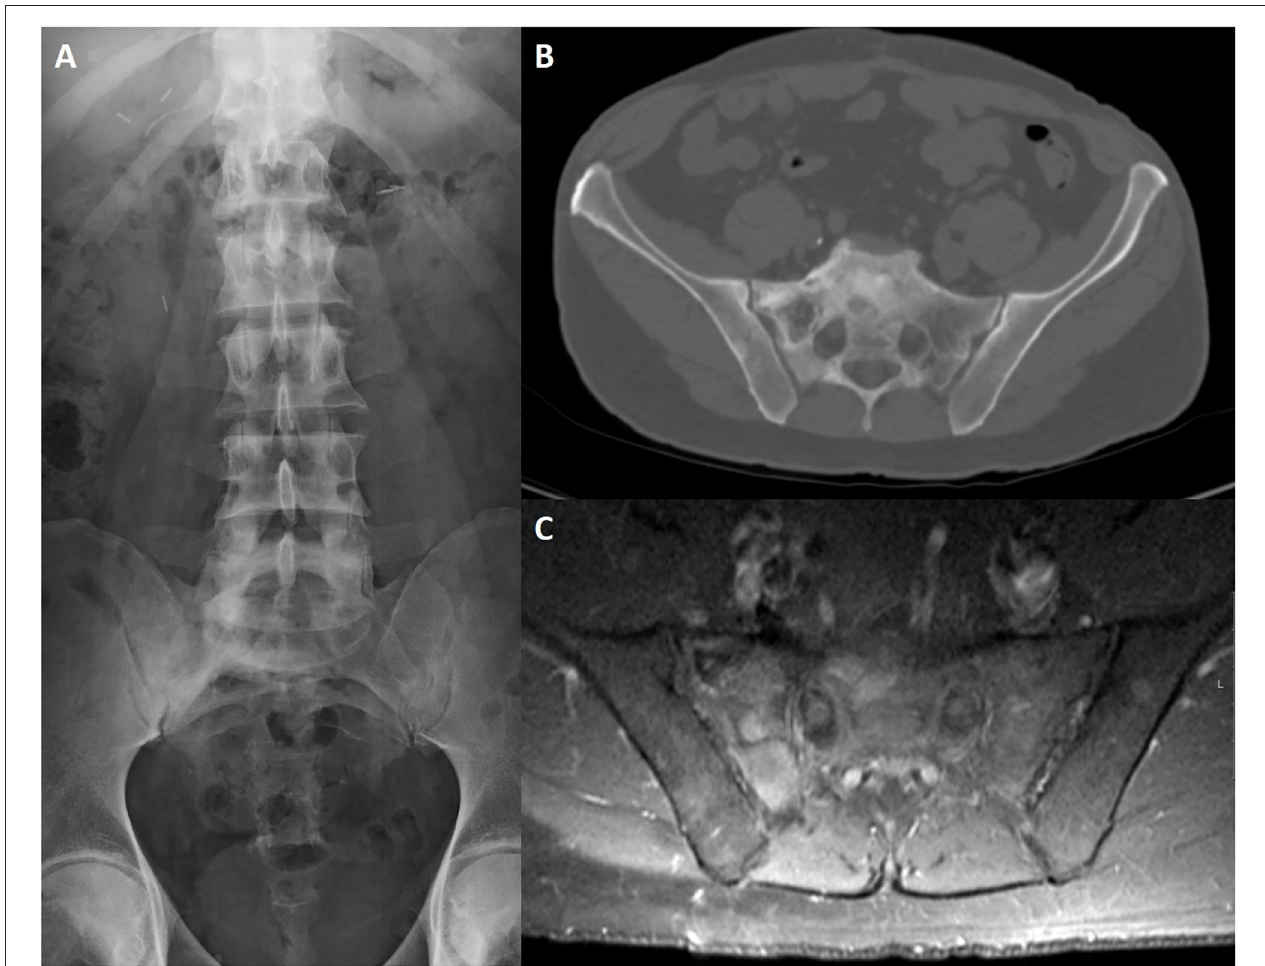
FIGURE 12 | Lumbosacral radiography (A) , CT axial slice (B) and post-contrast fat-saturated T1WI (C) of a 65-year-old male patient with Paget disease of the sacrum and right iliac bone. Typical findings include an expanded bone with coarsened trabecular pattern and sclerotic changes that are more evident on conventional radiography. There is increased uptake after intravenous contrast injection (C)